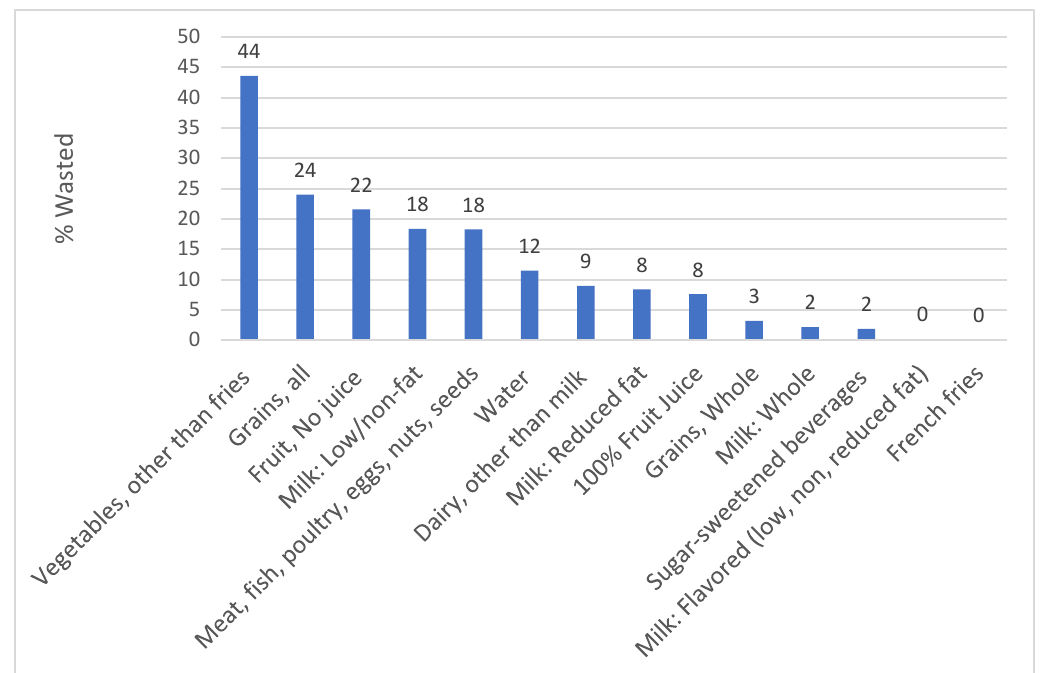
Figure 1. Percent of selected foods and beverages wasted in the absence of the policy, in reference to total amount served (North Carolina pre-and post-intervention plus South Carolina pre-intervention) ( n = 90 observations).